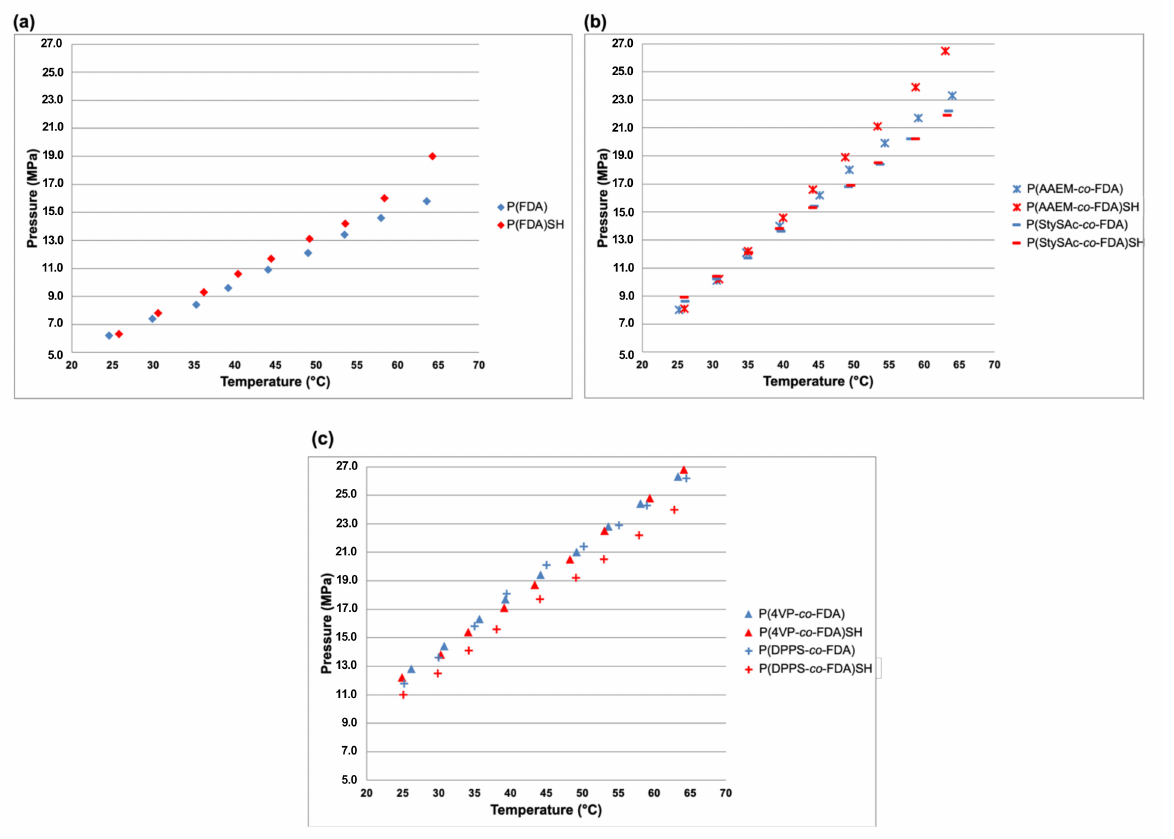
Figure 12. Cloud point curves in dense CO 2 for the synthesized polymers: ( a ) P(FDA) and P(FDA)SH; ( b ) P(AAEM- co -FDA), P(AAEM- co -FDA)SH, P(StySAc- co -FDA) and P(StySAc- co -FDA)SH; ( c ) P(4VP- co -FDA), P(4VP- co -FDA)SH, P(DPPS- co -FDA) and P(DPPS- co -FDA)SH (at a polymer concentration of ca. 1 wt% of polymer relative to CO 2